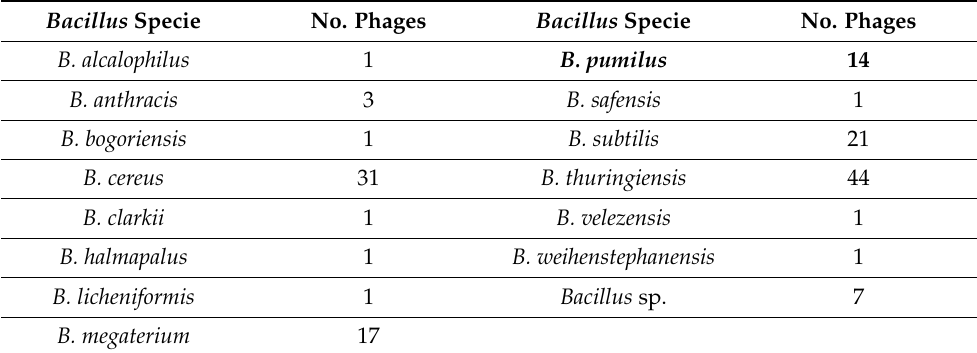
Table 5. Number of phages, with the available genome at NCBI *, described using a Bacillus strain as host (in alphabetical order).